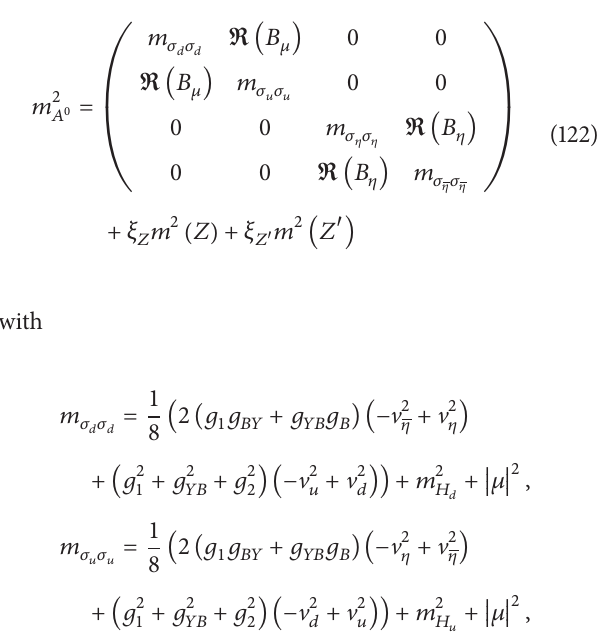
This matrix is block diagonal for 𝑔 𝐵𝑌 = 𝑔 𝑌𝐵 = 0 with an upper 2 ×